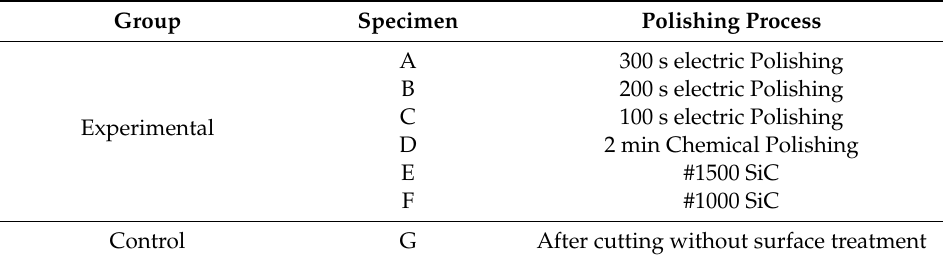
Table 1. Group of Ti-6Al-4V during di ff erent polishing